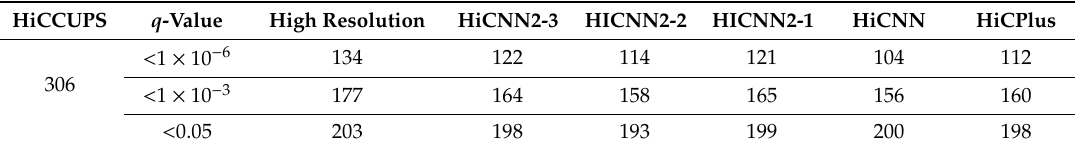
Table 1. The performances of HiCNN2-1, HiCNN2-2, HiCNN2-3, HiCNN, and HiCPlus for recovering significant interactions detected by Fit-Hi-C (with three di ff erent q -values) that are in common with 306 Hi-C peaks detected by HiCCUPS on chromosome 17 in human GM12878. The best overlapping numbers are highlighted (bold